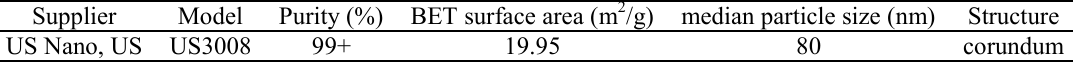
Characterization of alumina powder